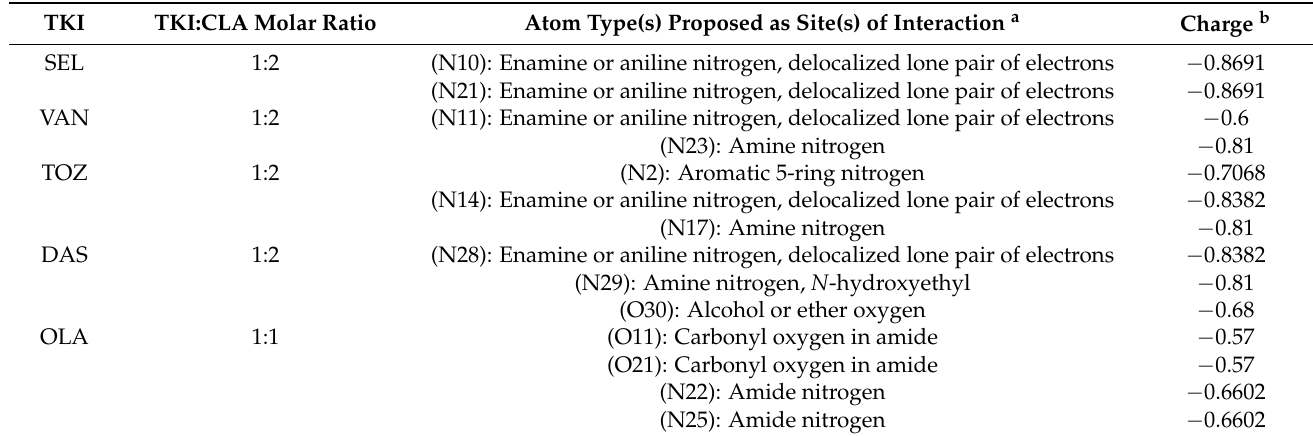
Table 3. The molar ratios of the reaction of TKIs with CLA, types of atoms proposed as site(s) of interaction on TKIs molecules and charges on these atoms.